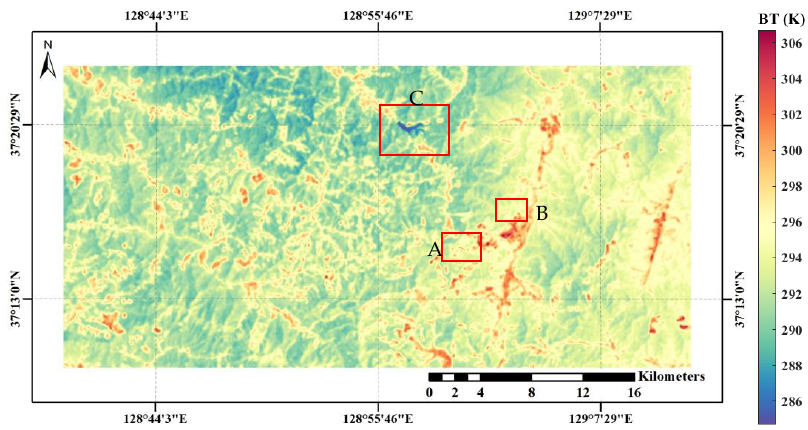
Figure 5. Proposed disaggregated brightness temperature results.